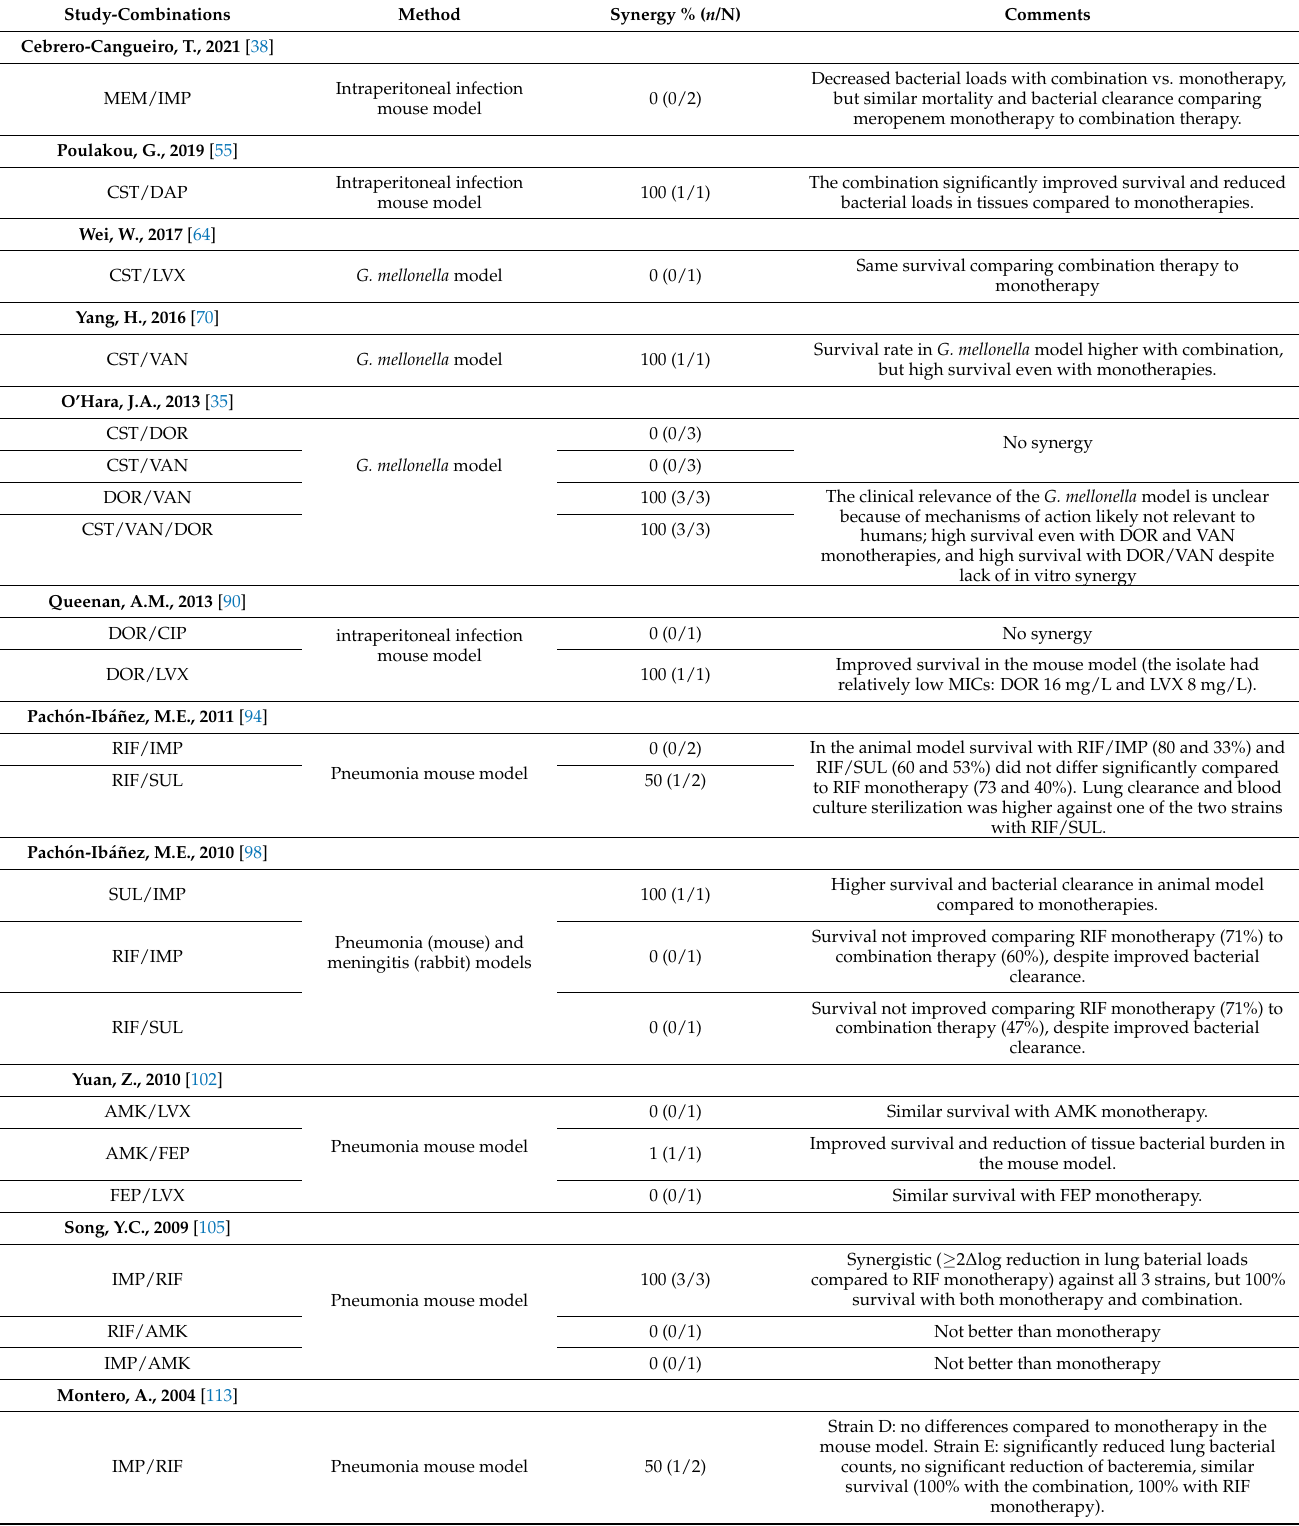
Table A5. Studies using animal